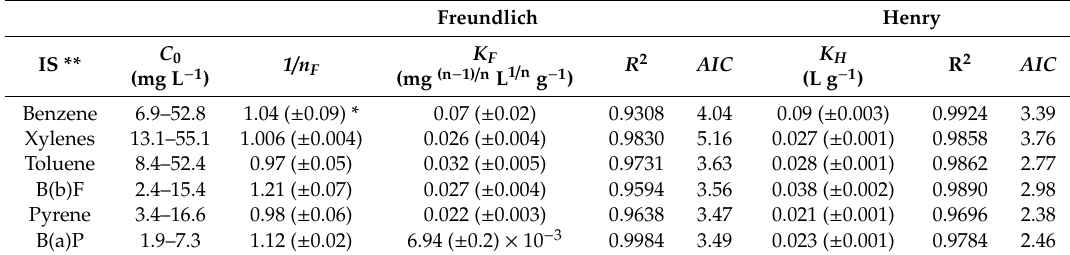
Table 3. Freundlich and Henry parameters obtained by fitting Equations (8) and (9) to the experimental data * (see Figure S4). Freundlich